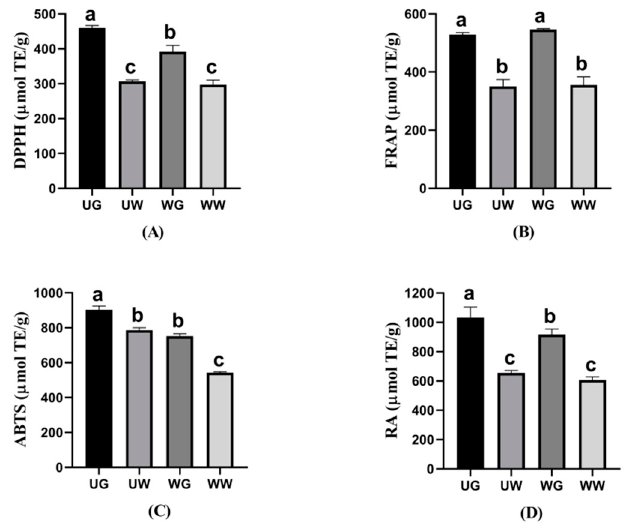
Figure 3. Antioxidant activities ( A ) DPPH, ( B ) FRAP, ( C ) ABTS, and ( D ) RA of TPC with four different treatments. Data are reported as mean ± SD ( n = 3). Different letters, such as a, b, and c, showed significant difference ( p < 0.05).